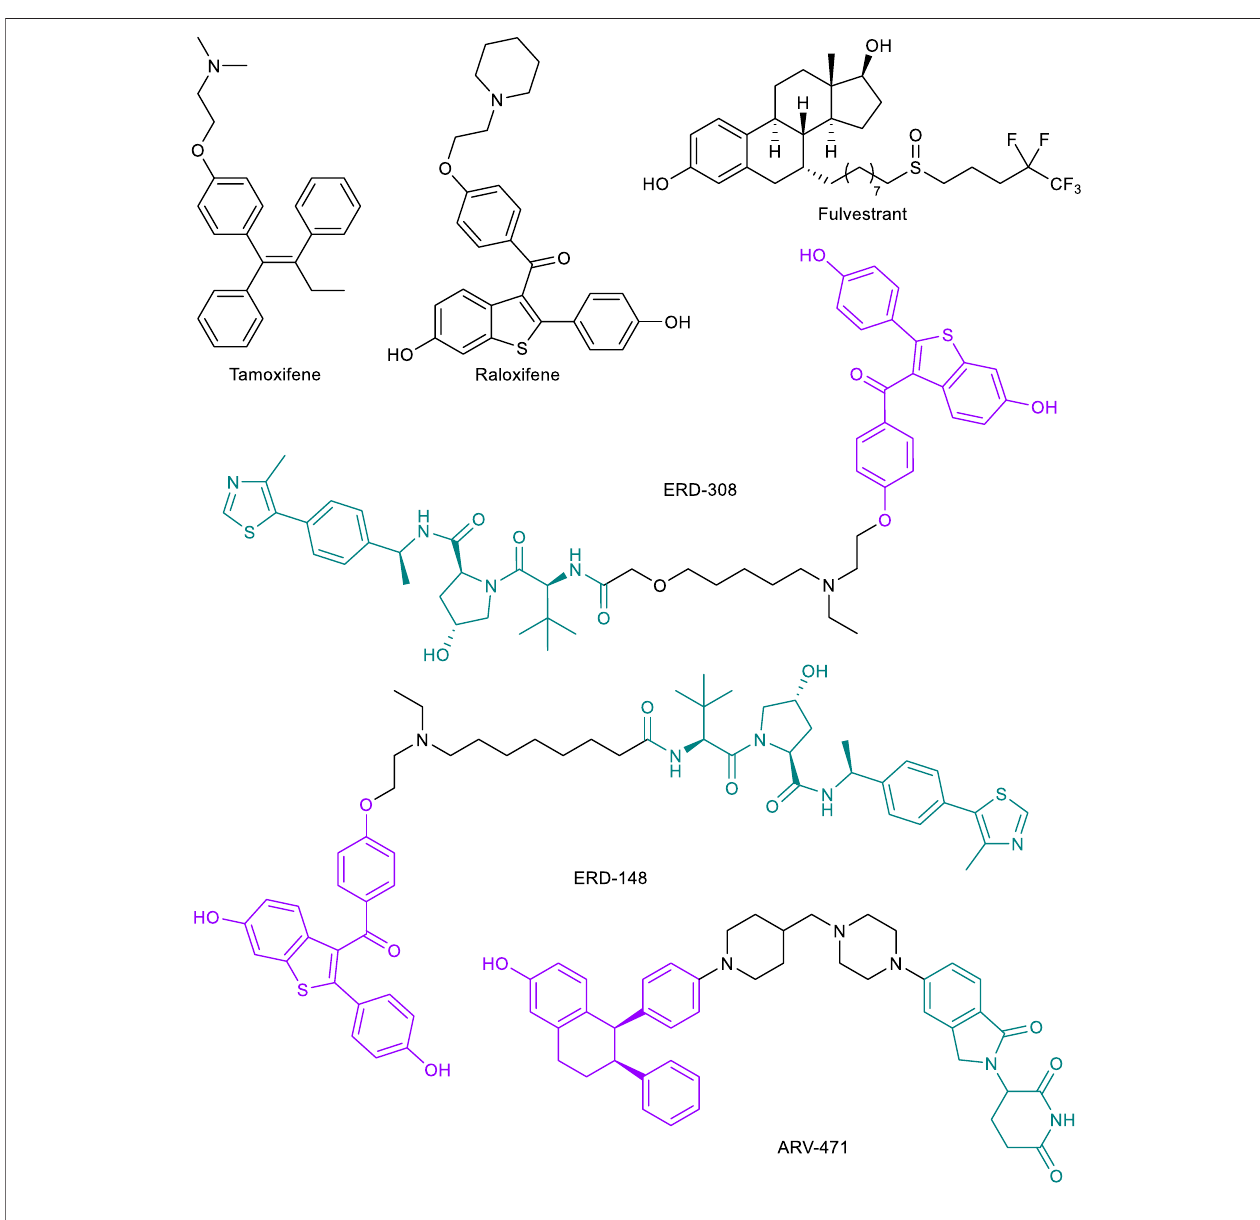
FIGURE 4 | Key ER small molecule inhibitors and ER-targeted